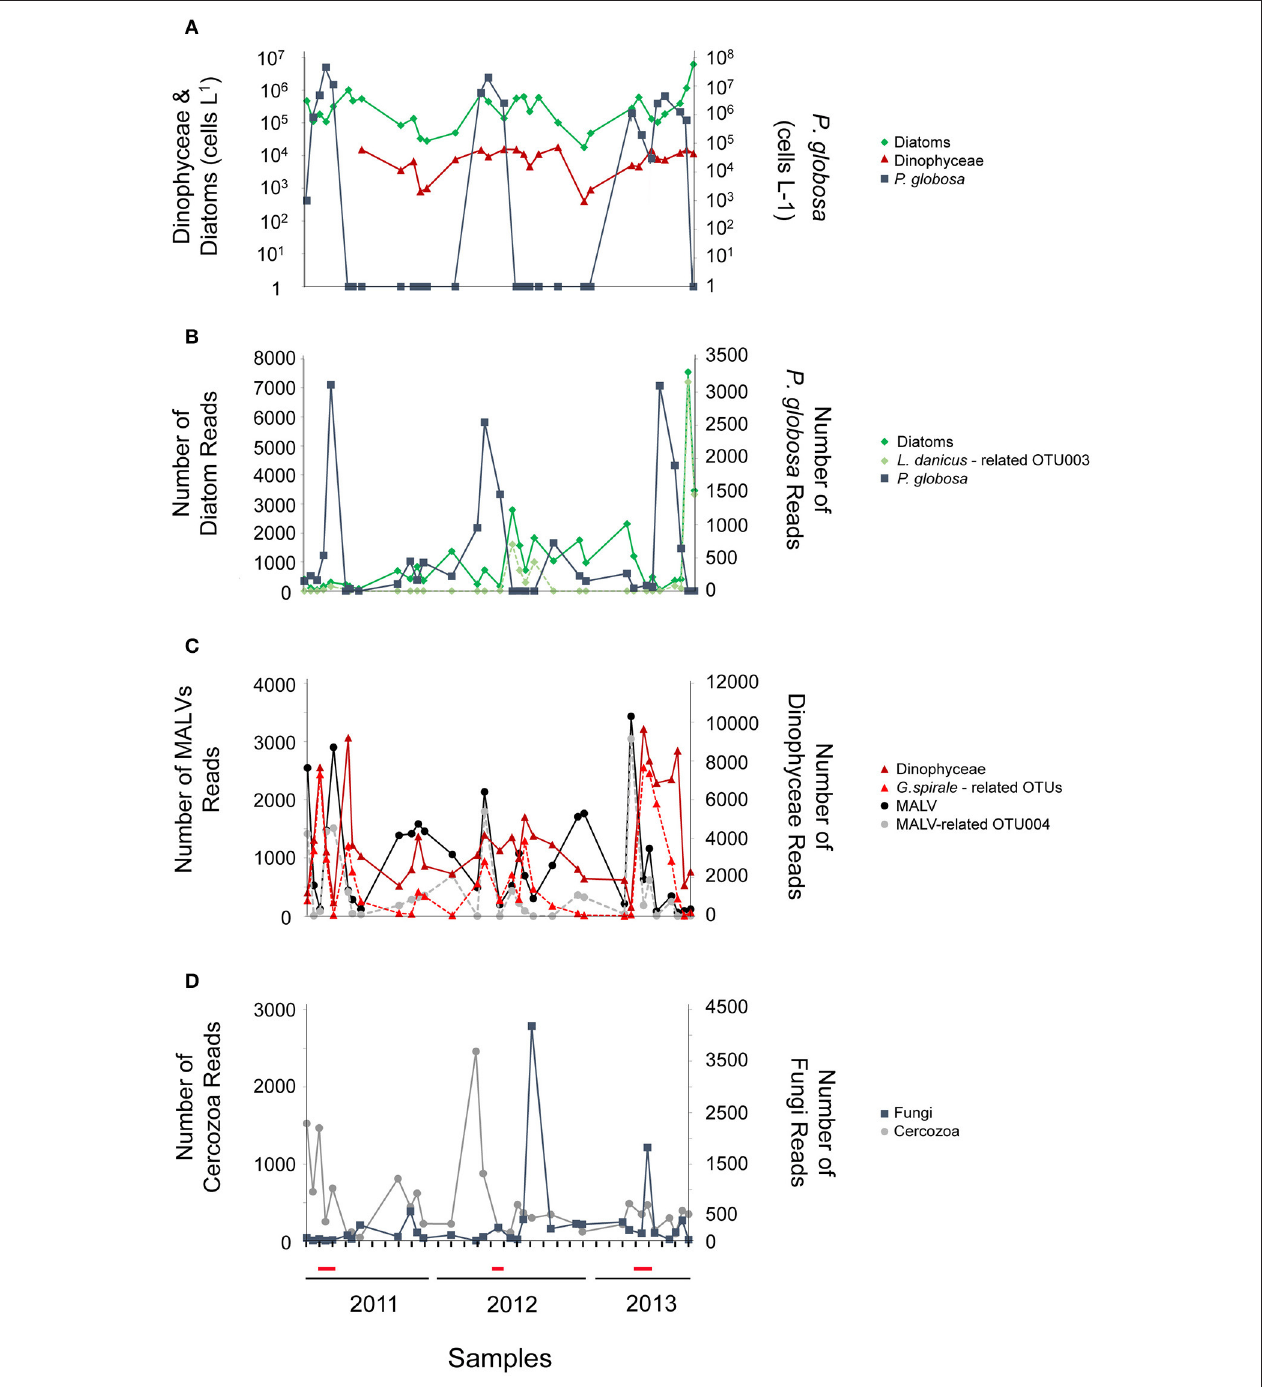
FIGURE 2 | Microscopic counts (cells L − 1 ) of diatoms (green line), dinoflagellates (red line) and Phaeocystis globosa (blue line) (A) ; Number of reads of diatoms (green line), the most abundant diatom OTU003 related to Leptocylindrus danicus (dotted light green line), and P. globosa (blue line) (B) ; Number of reads of heterotrophic dinoflagellates (red line), the most abundant dinoflagellate OTUs related to Gyrodinium spirale (dotted light red line), MALV (black line), and the most abundant MALV-related OTU004 (dotted gray line) (C) ; Number of reads of Fungi (blue line) and Cercozoa (gray line) (D) . The red line on the x-axis indicates periods of the P. globosa